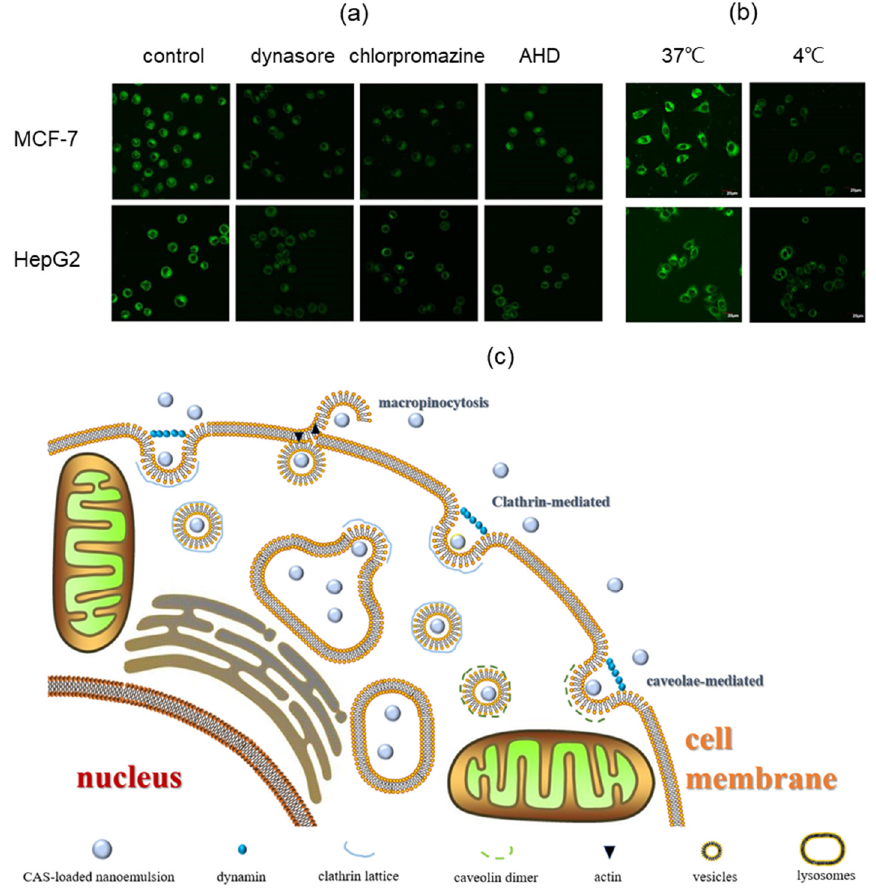
Figure 8. ( a ) Cellular uptakes of CAS-loaded nanoemulsions after incubating with MCF-7 and HepG2 after treatment with specific endocytosis inhibitors; ( b ) cellular uptake of CAS-loaded nanoemulsions after incubating with MCF-7 and HepG2 under different temperatures (37 °C and 4 °C) treatment for 30 min. The control was incubated with nanoemulsions without inhibitors. ( c ) Illustration of the protentional endocytic pathways for uptake of CAS-loaded nanoemulsions.